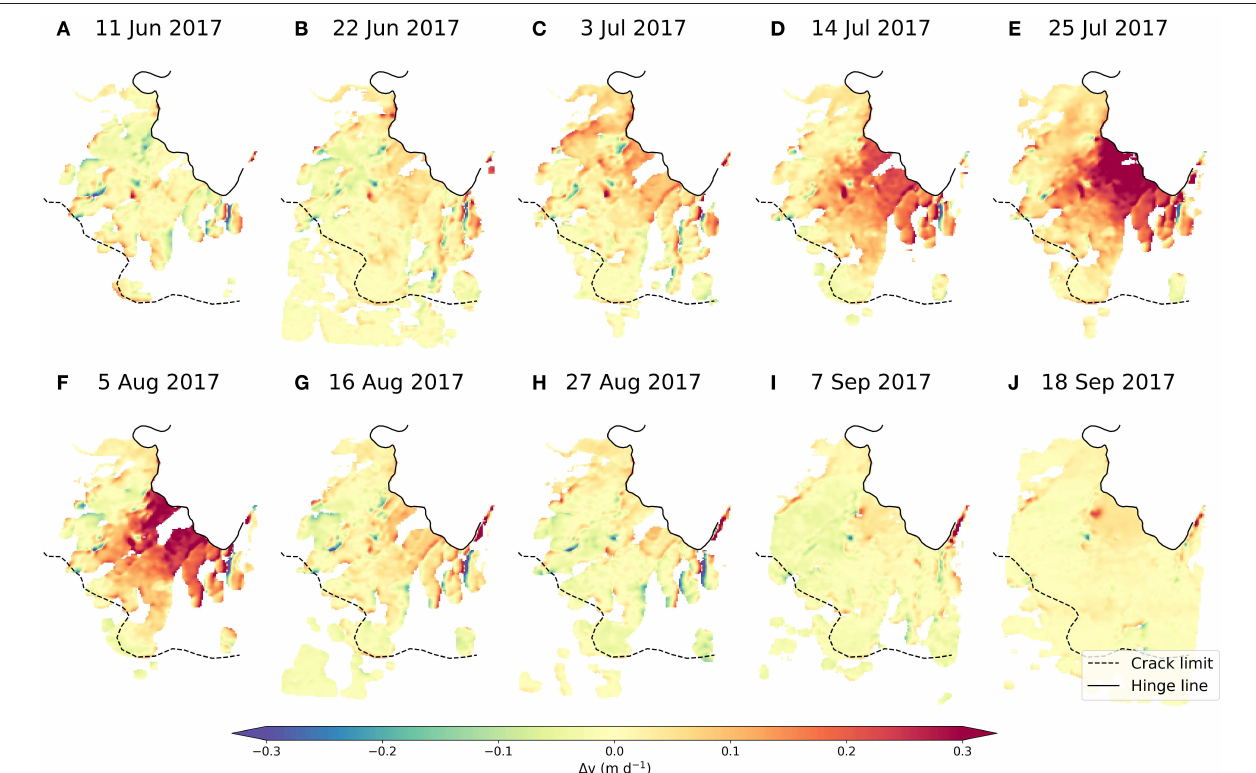
FIGURE 6 | Increase (A–F) and decrease (G–J) in 2017 surface velocities upstream the hinge line (solid black line) of 79 ◦ N Glacier when compared to winter velocities of the same year. Dates are the center dates between the 11-day repeat pass of TerraSAR-X employed in the generation of the summer velocity fields. Winter velocites were derived from TerraSAR-X data acquired between 10 December 2017 and 21 December